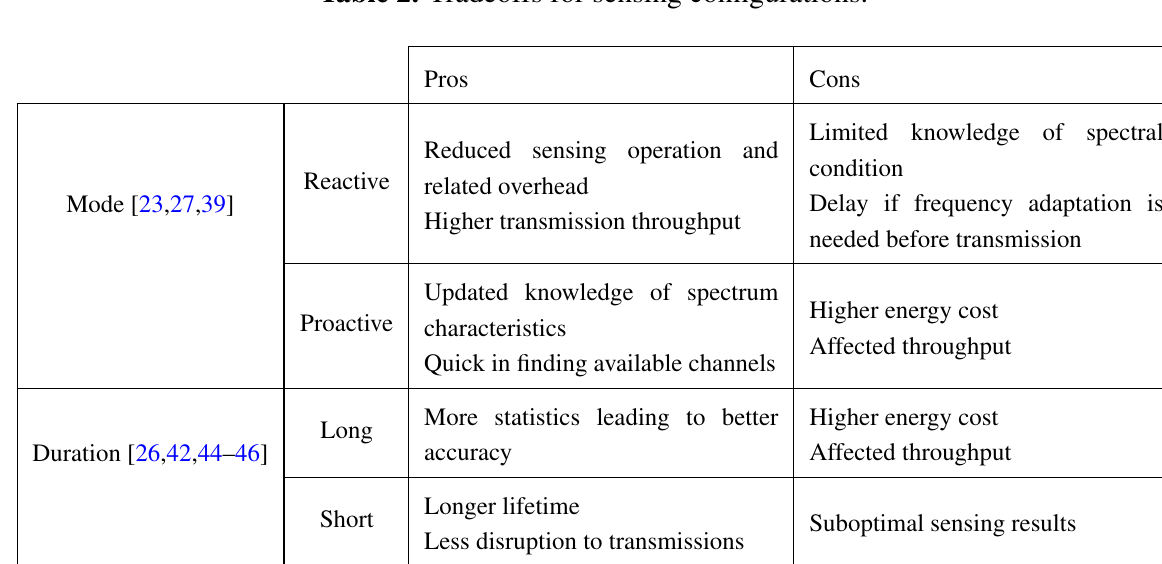
Table 2. Tradeoffs for sensing